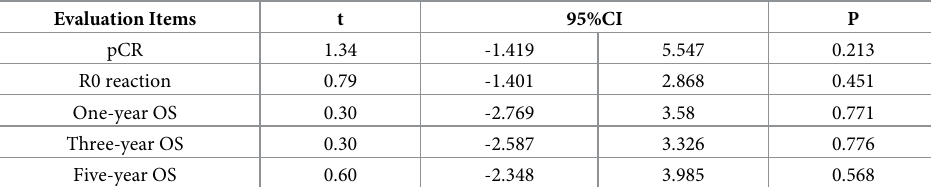
Table 3. Publication bias results of the included